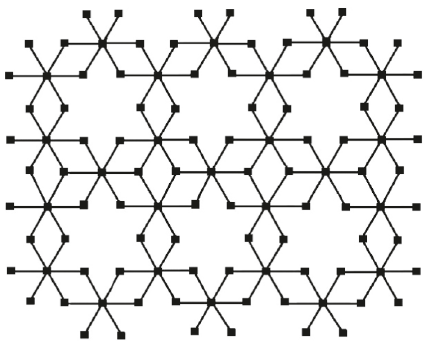
Table 2: Edge partitioning based on degree of m − BiI